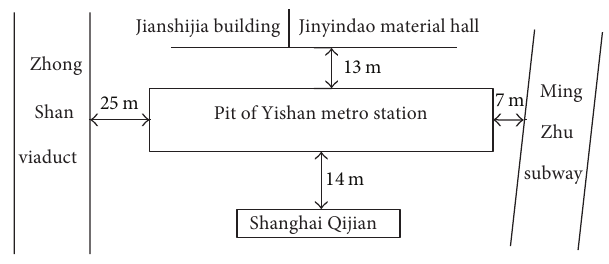
Figure 1: Layout of Yishan metro station.